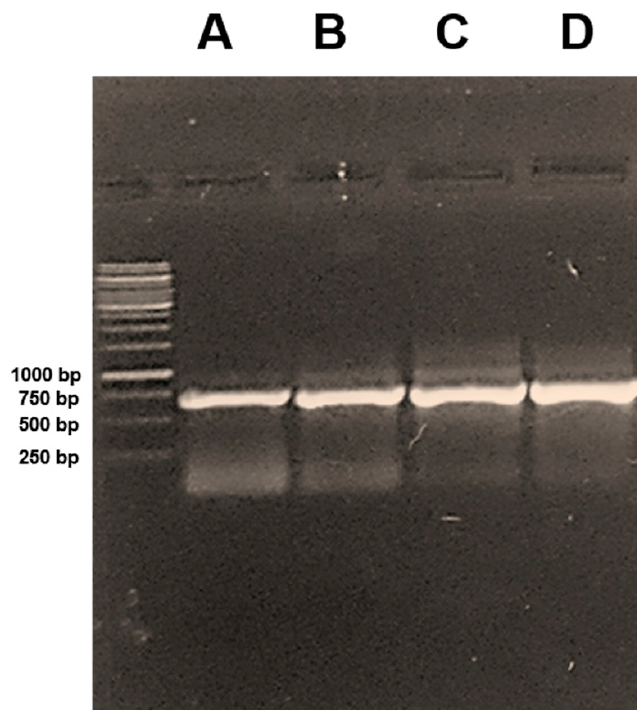
Figure 3. 650 bp COI-based PCR amplicons for example sampled from Leiurus quinquestriatus ( A ), Androctonus amoreuxi ( B ), Orthochirus Innesi ( C ), Buthacus leptochelys ( D ).